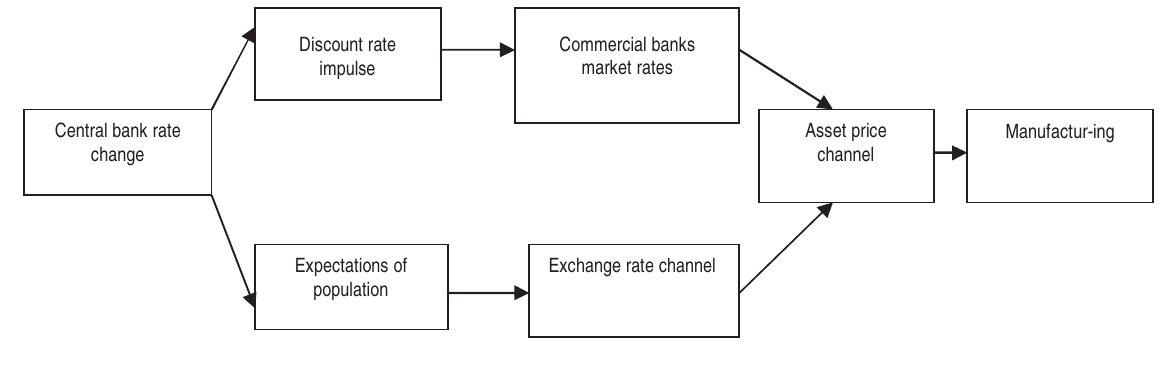
Fig. 2. The place of asset price channel in the transmission mechanism